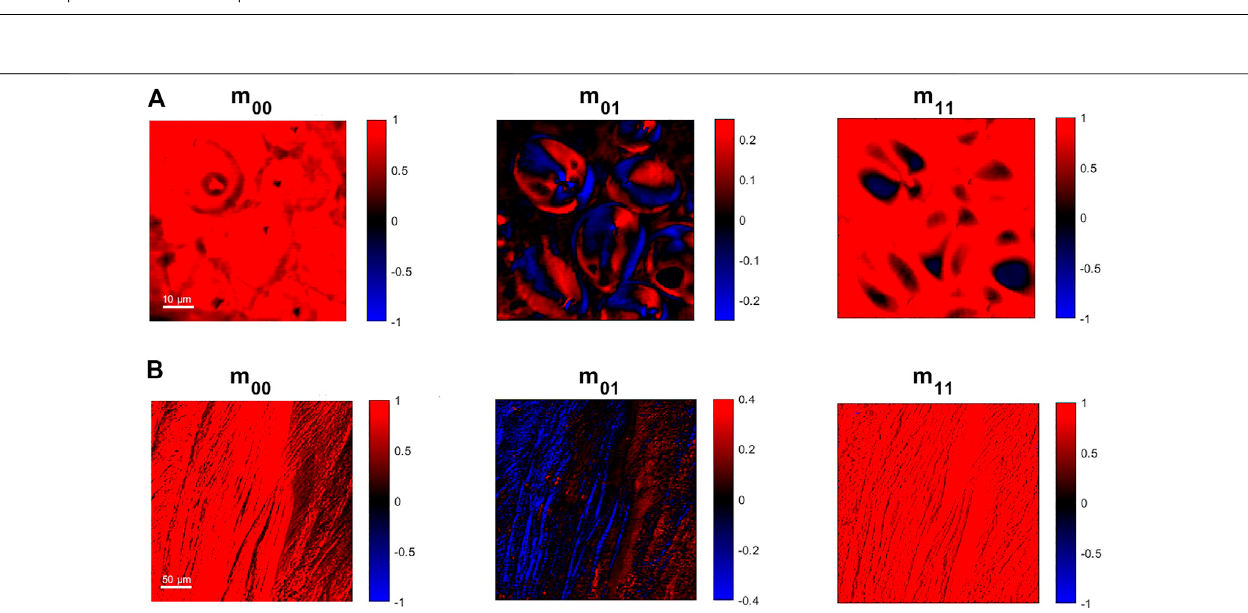
FIGURE4| 512 × 512pixelsimagesobtainedfromtheZeeman lasermethod implemented intoanopticalscanningbeamarchitectureassociatedwiththeMueller coef fi cients obtained by the analysis of the Zeeman Beating signal. (A) Images of starch granules from a potato thin-cut slice. (B) Images of collagen fi bres from a rat